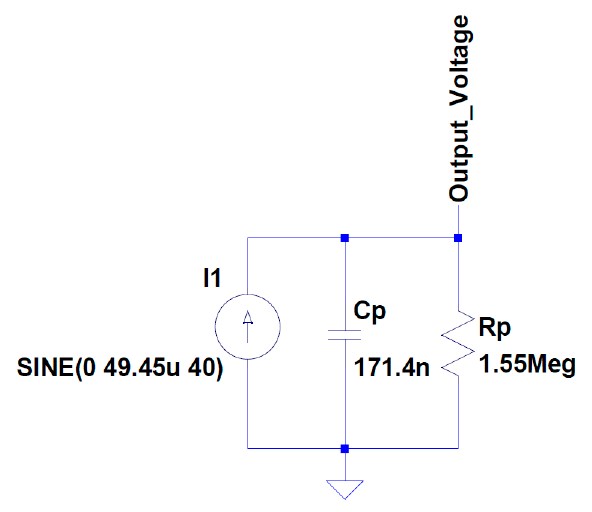
Figure 13. Piezoelectric SPICE model for QP20W transducer.